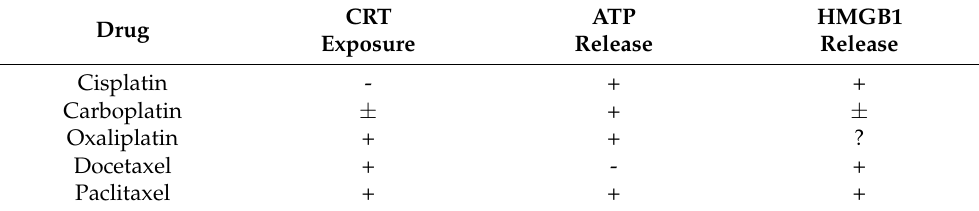
Table 1. The induction of main ICD-associated